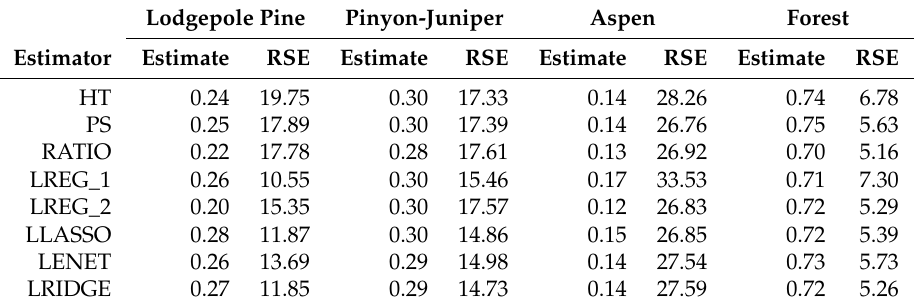
Table 2. Proportion estimates (Estimate) and relative standard errors (RSE) for the categorical forest